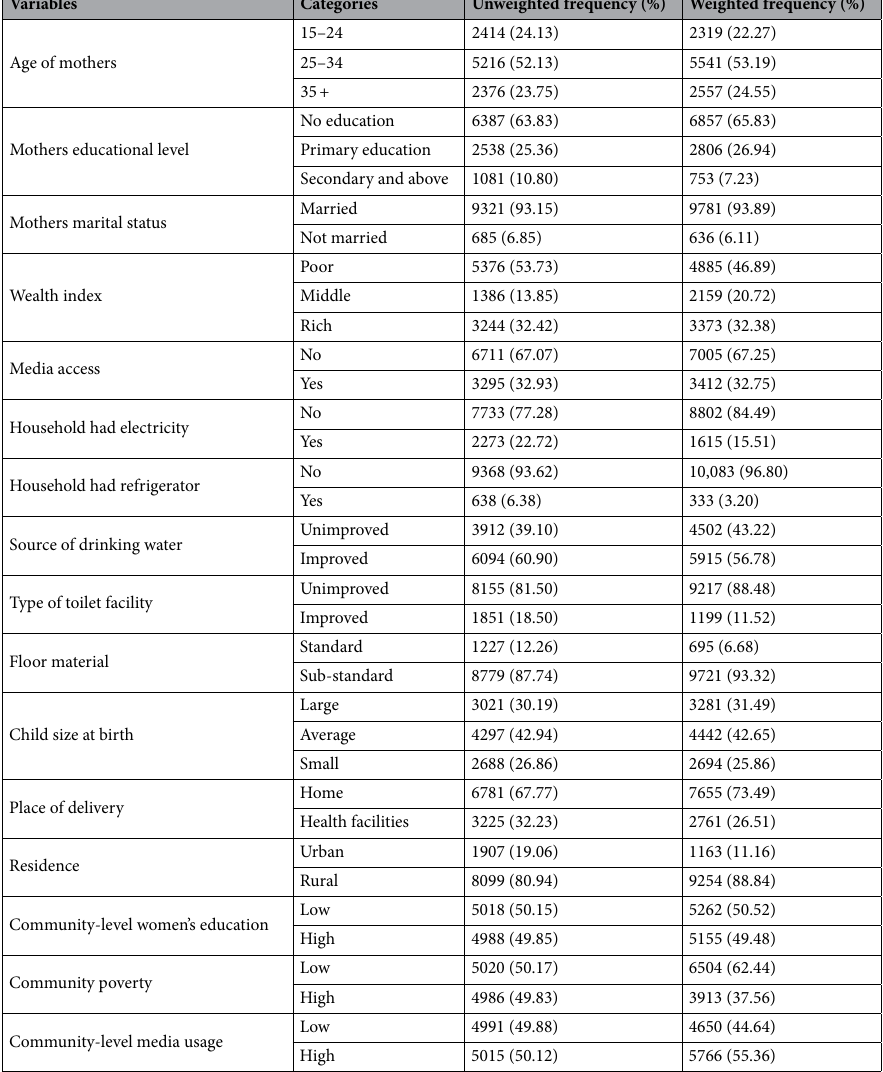
Table 1. Socio-demographic and economic characteristics of respondents in Ethiopia,